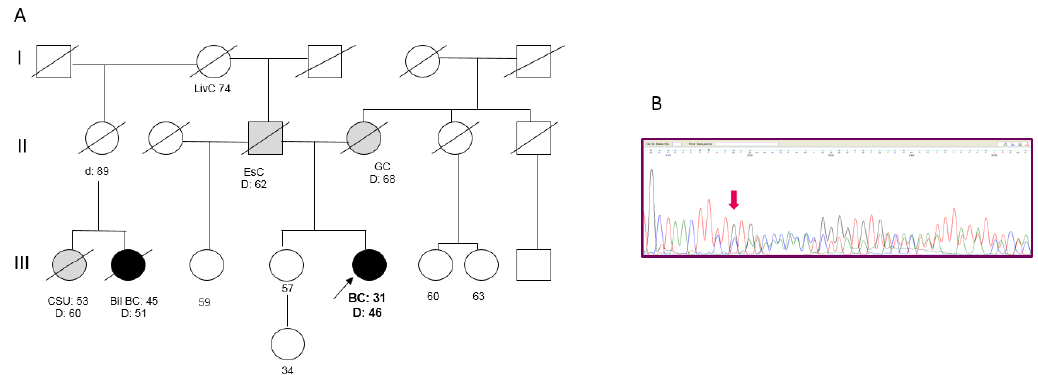
Figure 3. ( A ) Pedigree of Patient 3. (BC = Breast Cancer; Bil = Bilateral; EsC = Esophageal Cancer; GC = Gastric Cancer; LivC = Liver Cancer; CSU = Cancer of Site Unknown). ( B ) Targeted sanger sequencing of DNA extracted from BC tissue of Patient 3: electropherogram showing the c.156_157delTT at the heterozygous state.